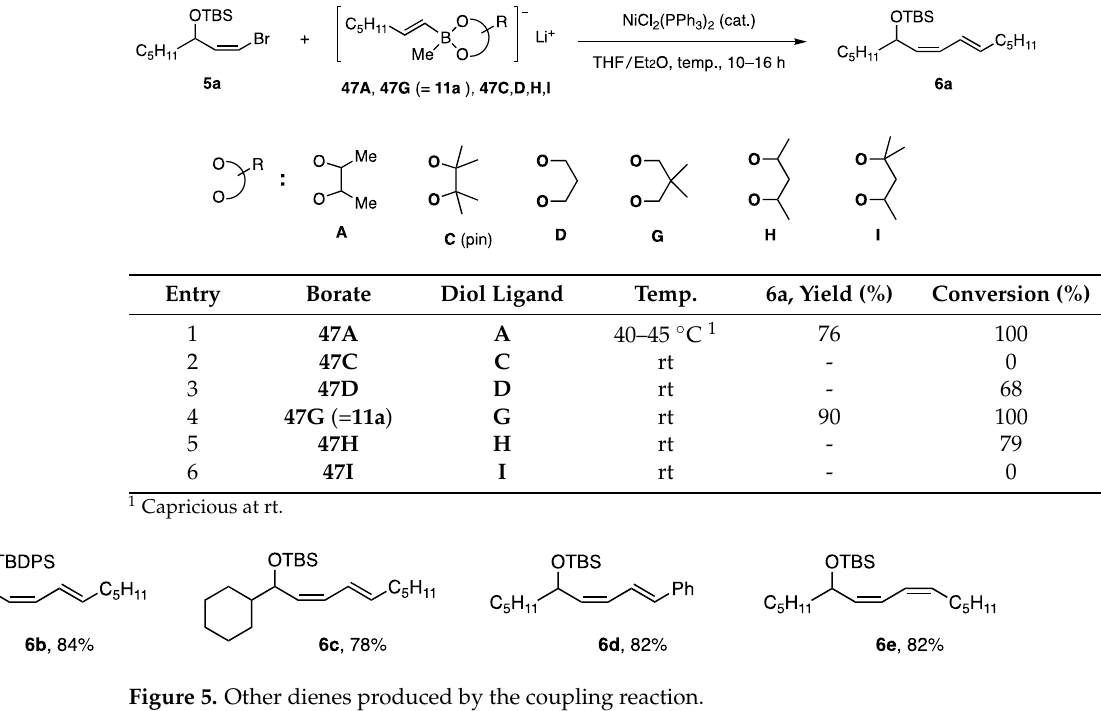
Table 4. Preliminary coupling reaction of (cis-bromo)olefin 5a with alkenyl borates possessing diol ligands.